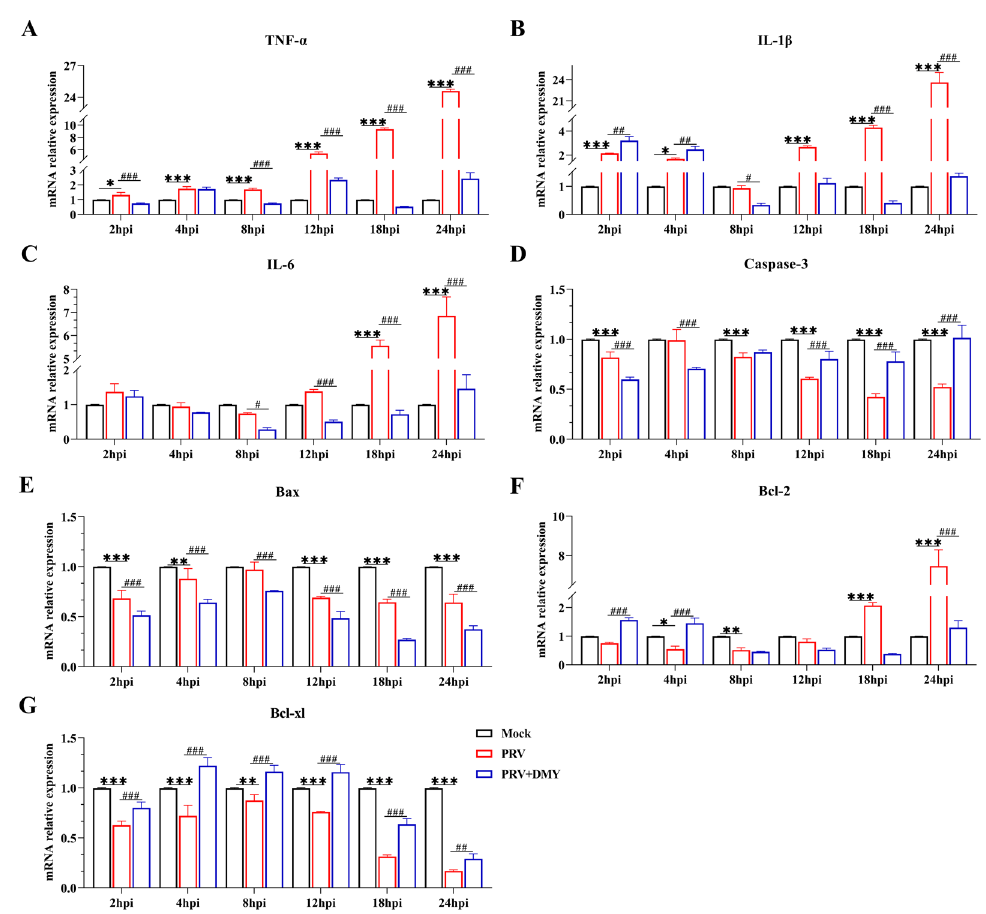
Figure 5. Effects of dihydromyricetin on gene expressions at 2, 4, 8, 12, and 24 hpi. The NF- κ B signaling pathway’s genes involved are TNF- α , IL-1 β , and IL-6. Caspase-3, Bax, Bcl-2, and Bcl-xl are apoptotic factors. Mock, uninfected-untreated group; PRV, infected-untreated group (MOI = 1); PRV + DMY, infected-treated group; the concentration of DMY was 500 µ M. Symbol *** denotes p < 0.001 when compared with mock group. Symbols *, **, and *** denote p < 0.05, p < 0.01 and p < 0.001, in several, as compared to the mock group. When compared to the PRV group, Symbols #, ##, and ### indicate p < 0.05, p < 0.01 and p < 0.001, respectively.